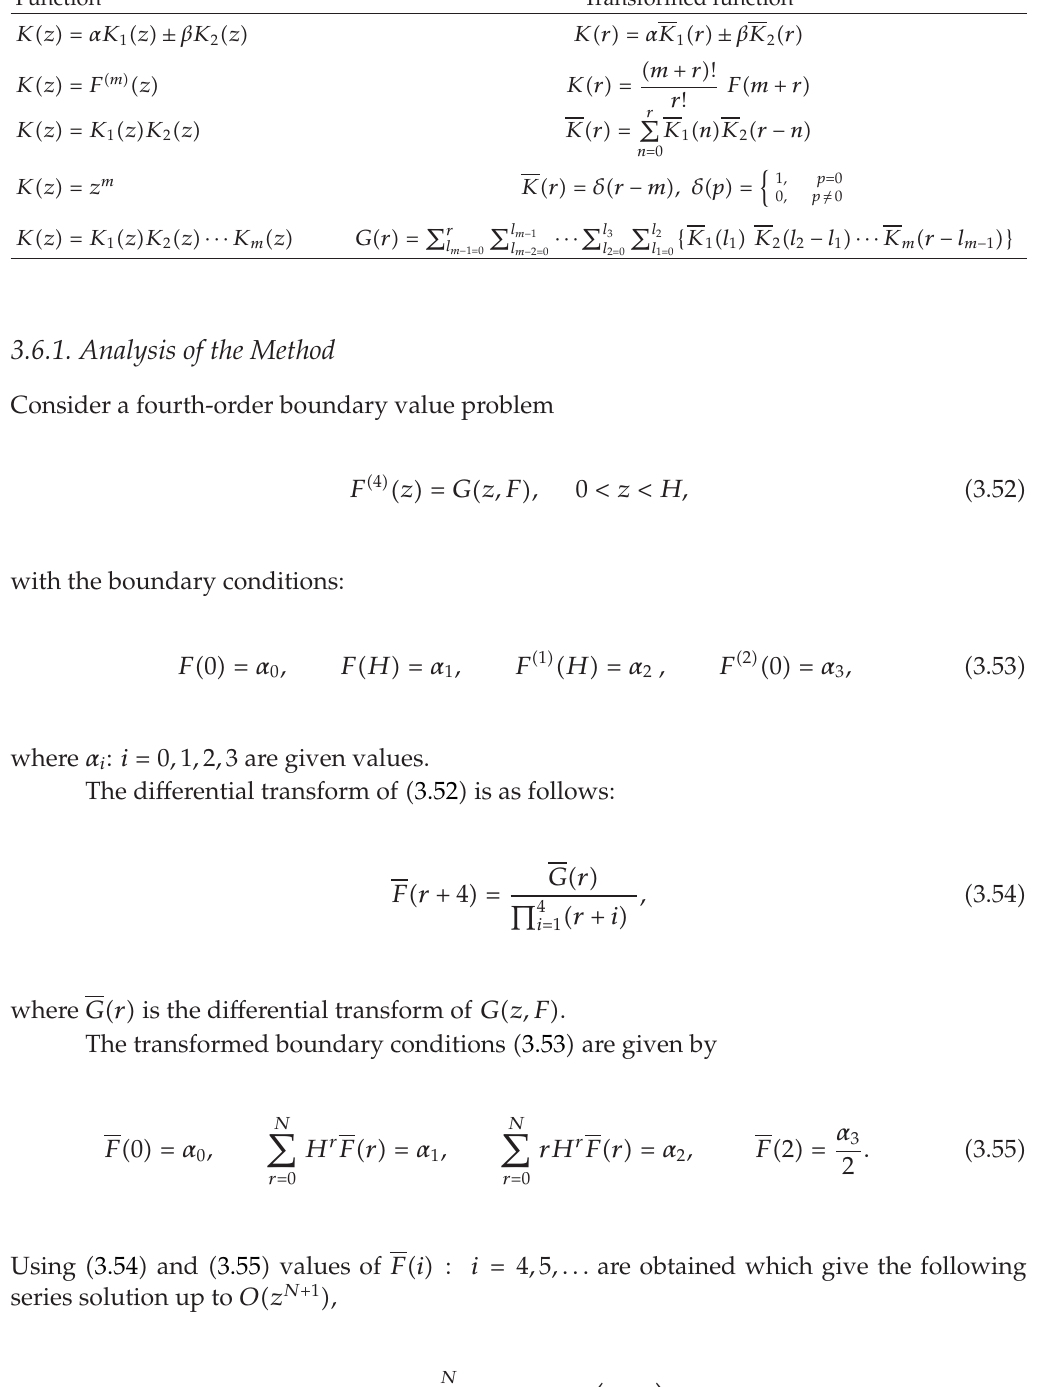
Function Transformed